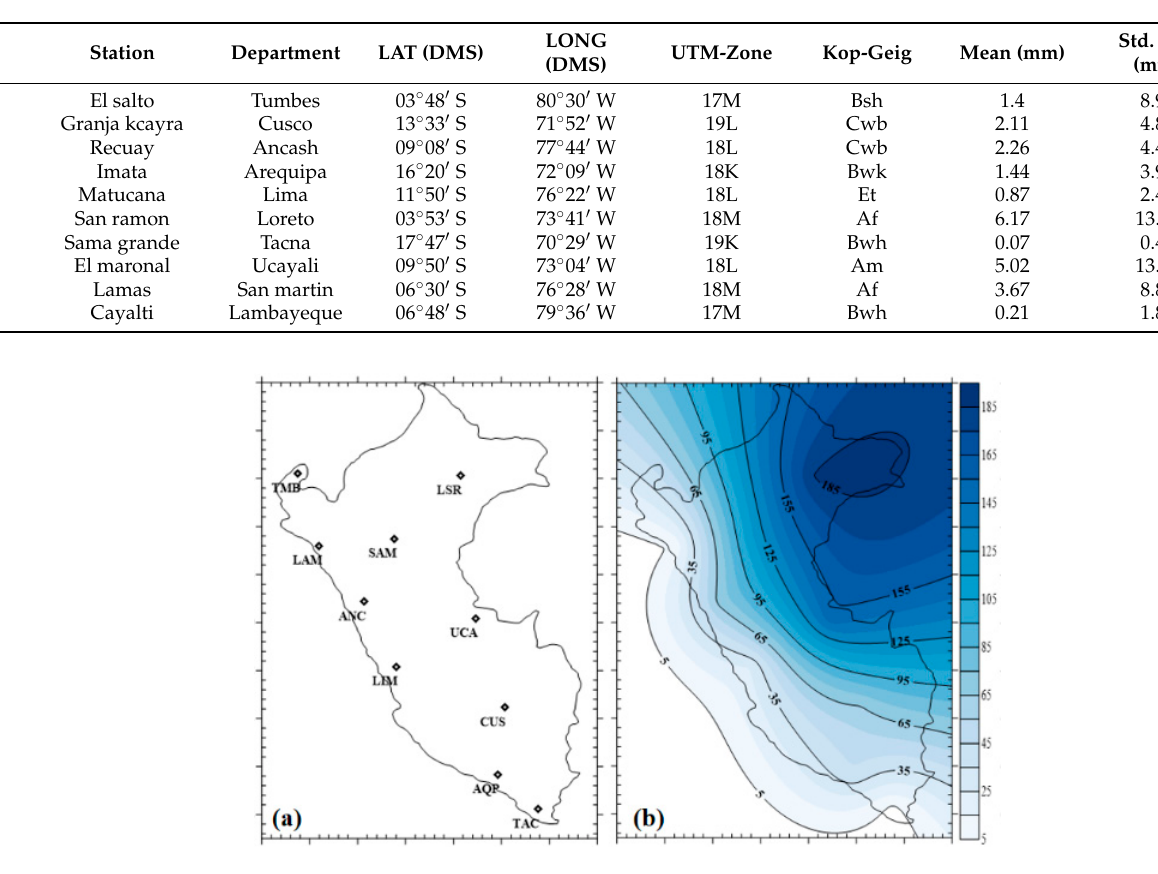
Figure 2. The projection of the data in the selected stations ( a , b ) the monthly total of the precipitation. Table 2. SPI classification according to the drought phase